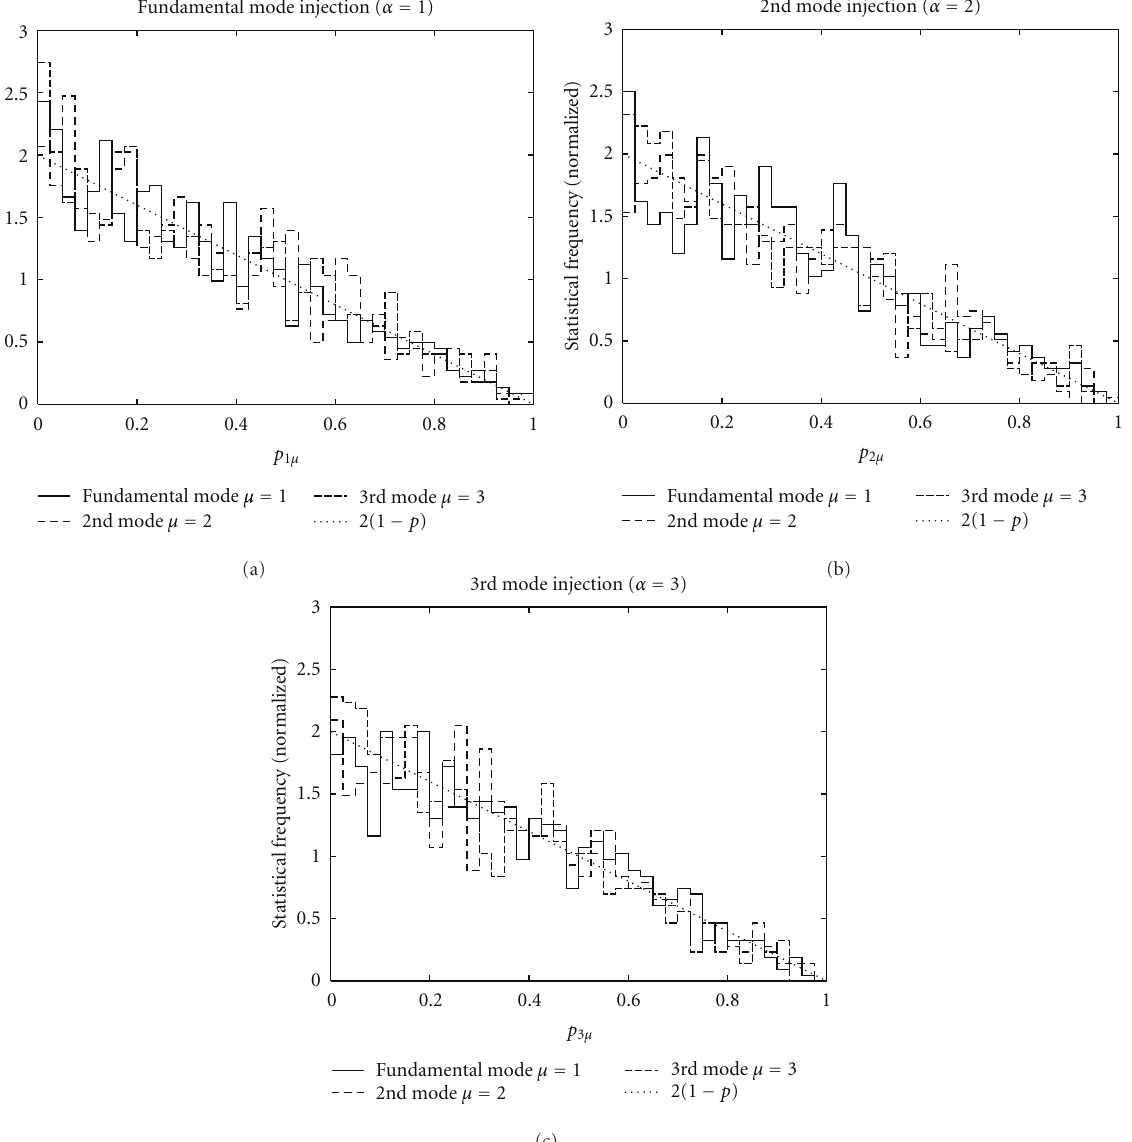
Figure 9: Frequency distributions for the fraction p αμ of each propagating mode in the transmission current carried by each propagating mode when each of three propagating modes is incident for Kd =